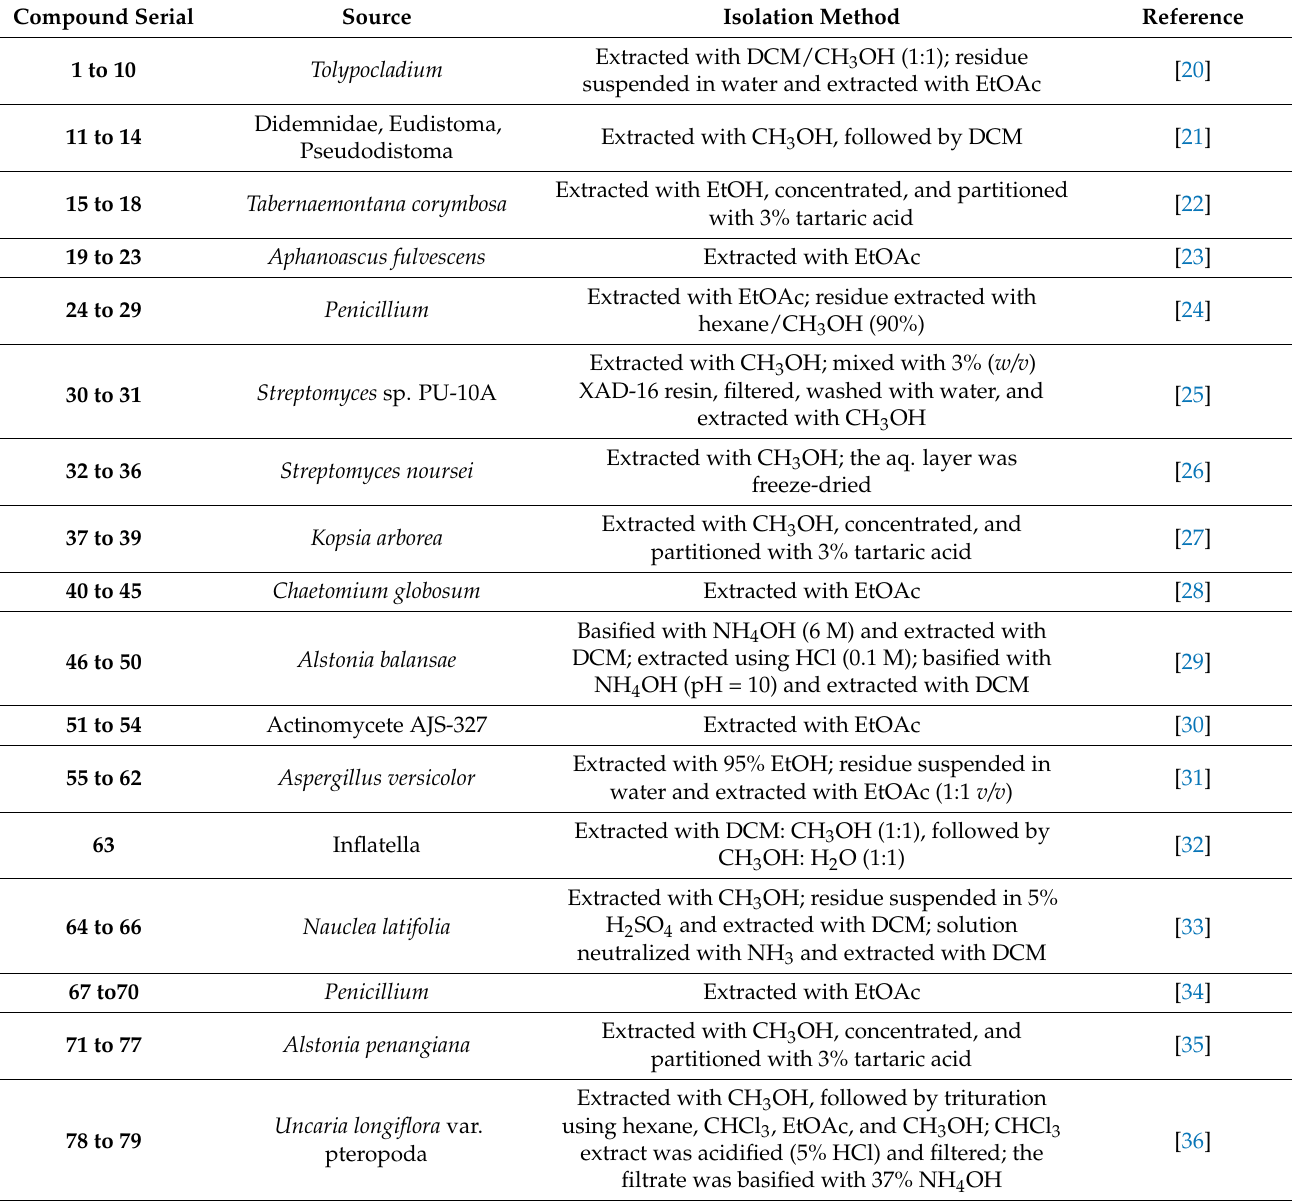
Table 1. Sources and isolation procedures of novel indole alkaloids ( 1–250